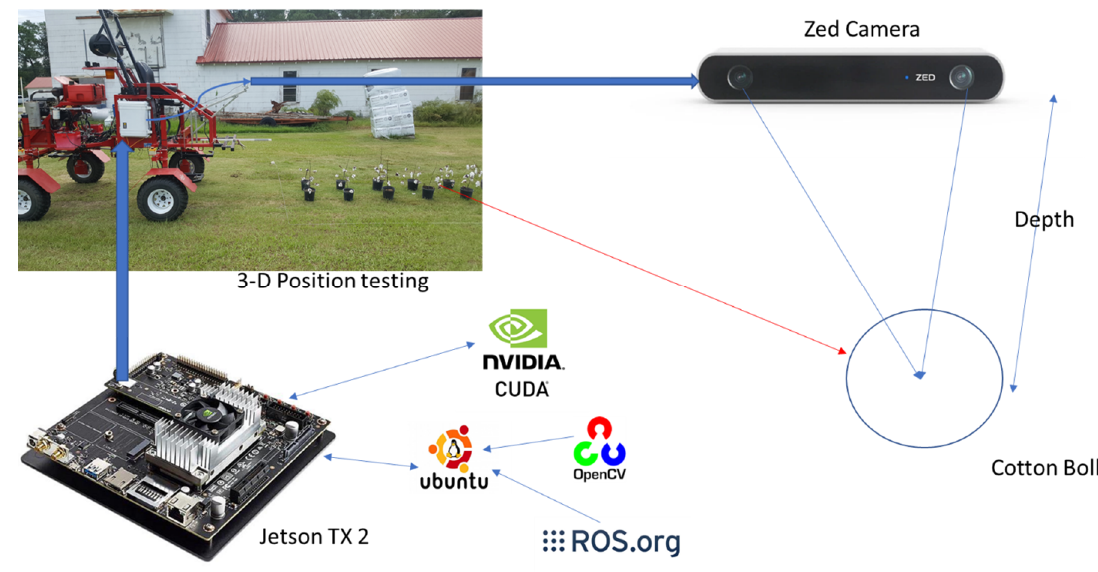
Figure 1. Machine vision components of the research.